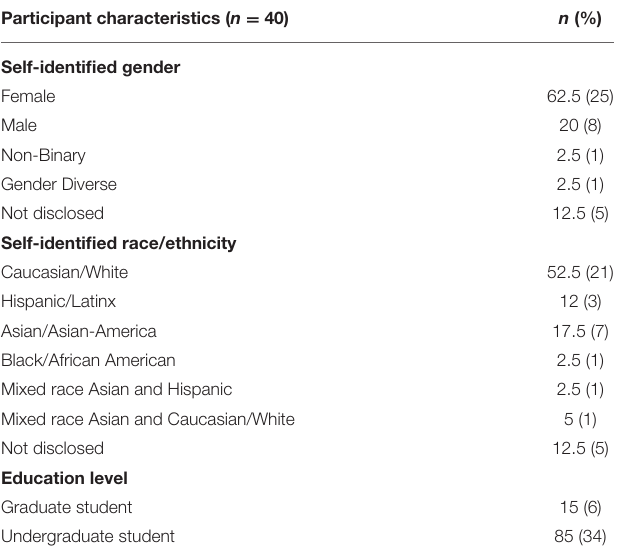
TABLE 1 | Participant demographic